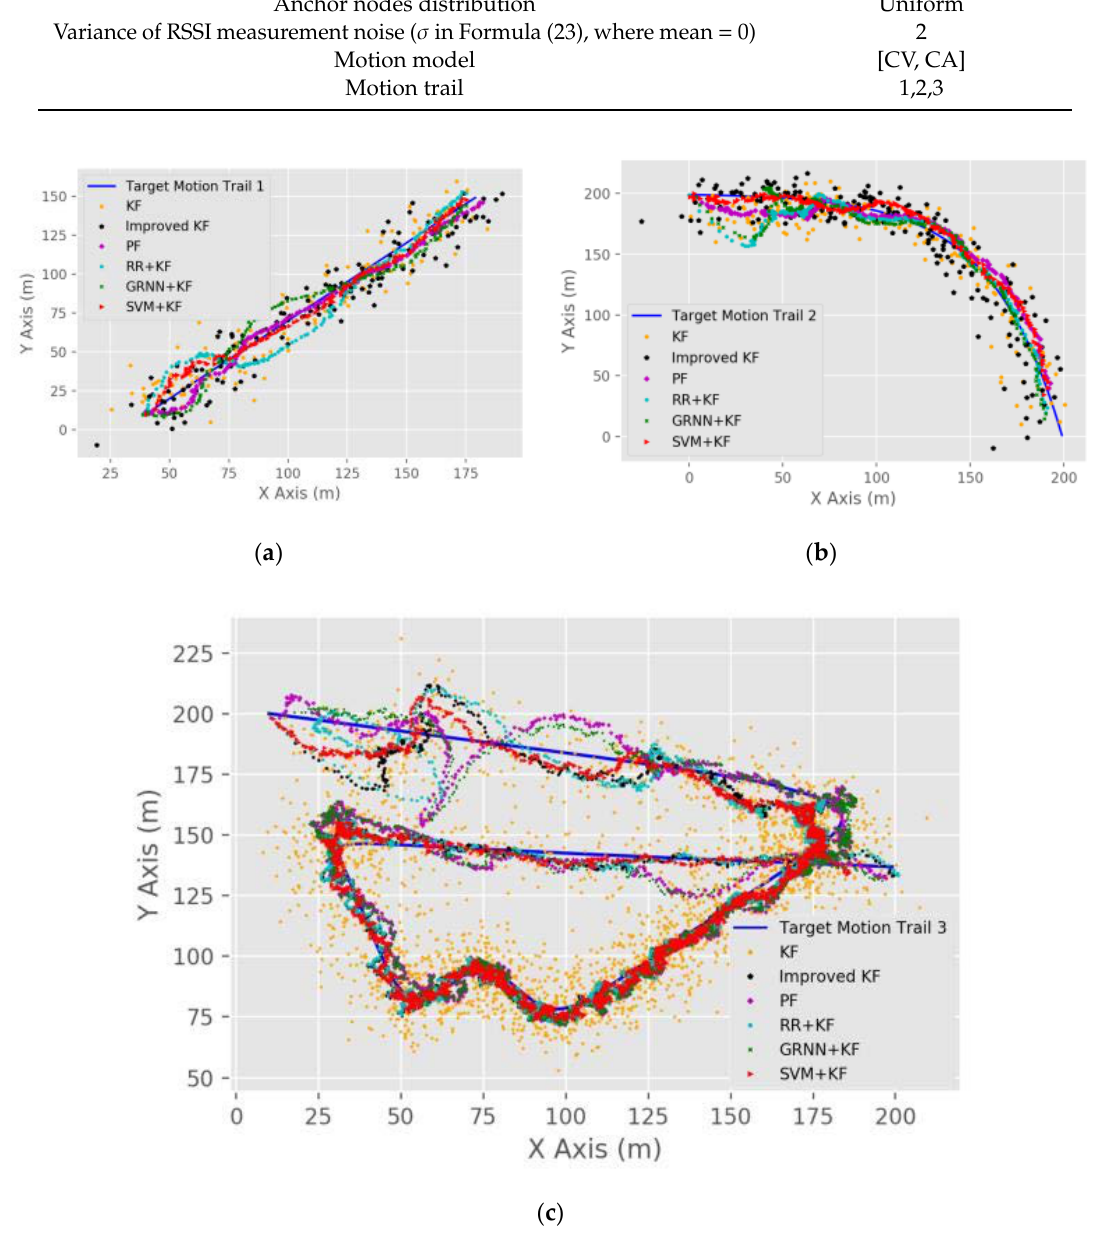
Figure 5. Results of different target motion trails: ( a ) Simulation results of trail 1; ( b ) simulation results of trail 2; ( c ) simulation results of trail 3.